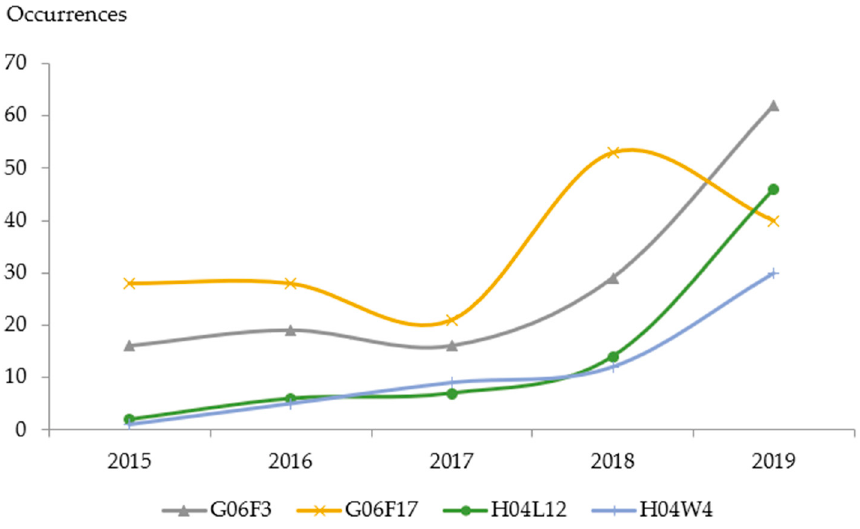
Figure 4. Key machine-learning technologies in optical communications over the years.